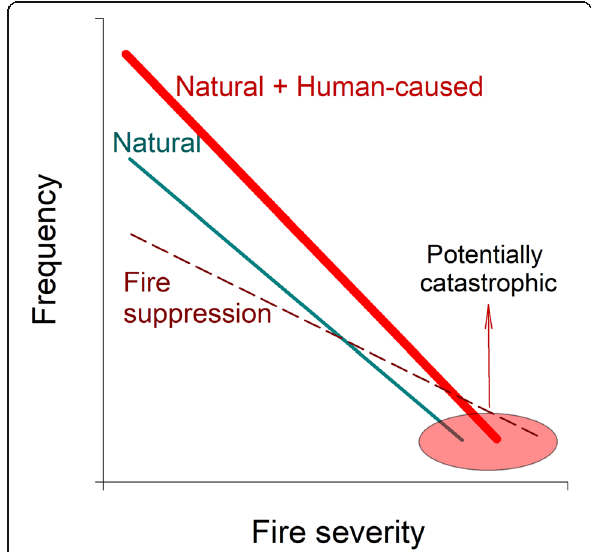
Fig. 1 A model showing various frequency distributions (log) of fire severity or size (log rank order) in nature vs. under growing human activities based on Zipf's Law. In many ecosystems, small and less severe fires are numerous but large and highly severe ones are few; that is, the frequency distribution of fire intensity (severity) or size usually follow the Zipf ’ s Law. Human activities increase the probability of fire, but total fire suppression usually reduces the occurrence of naturally occurring small- and middle-sized fires and could increase the risk of unintended catastrophic fires due to a large amount of accumulated